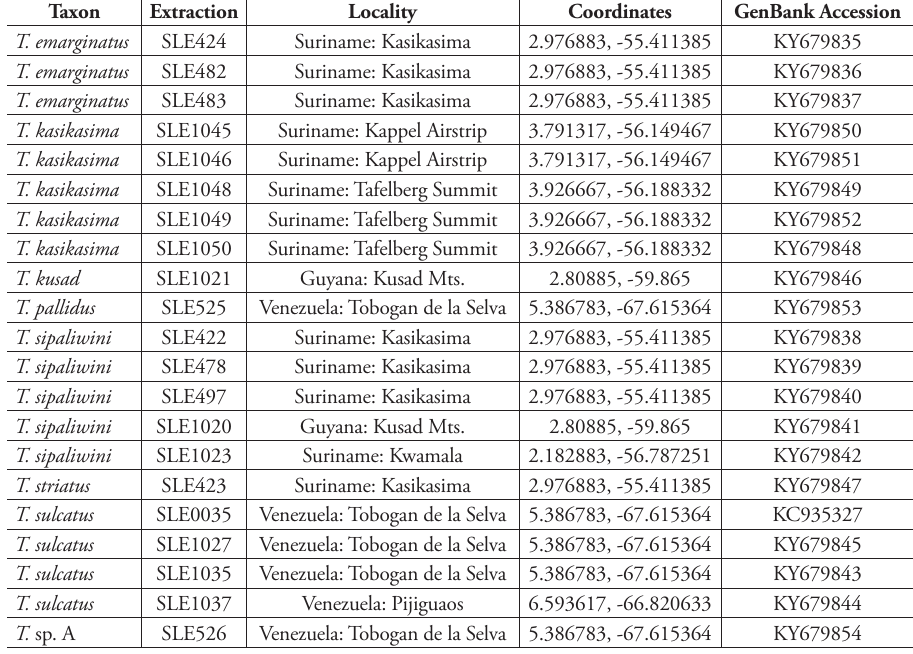
Table 1. List of specimens and GenBank accession numbers used in this study. All vouchers are deposited in